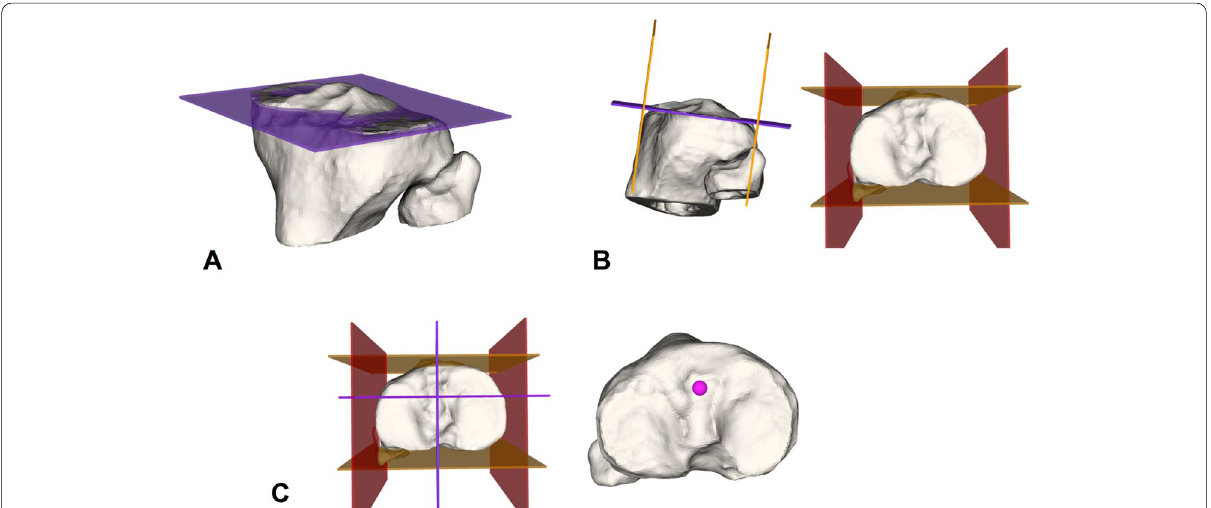
Fig. 1 Tibial ACL insertion. Definition of 3D tibial ACL insertion based on Stäubli et al. [29] and described in the